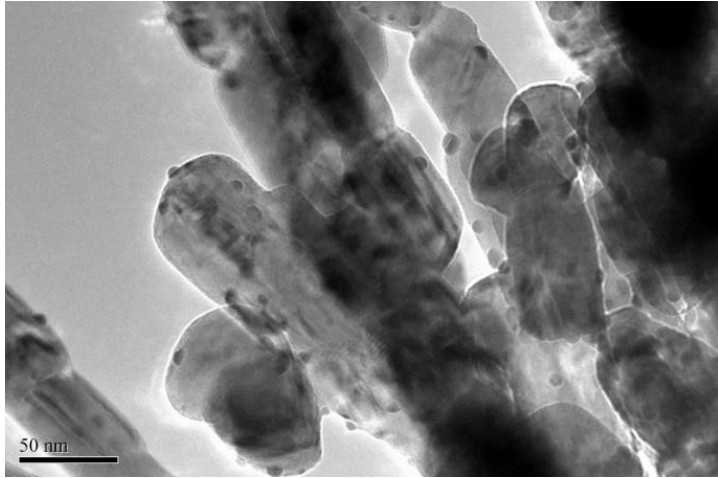
/ CuO-300 after the CO oxidation reaction of 20 h at 180 ◦ Figure 10. TEM image of Au 1.0 /CuO-300 after the CO oxidation reaction of 20 h at 180 °C. Figure 10. TEM image of Au 1.0